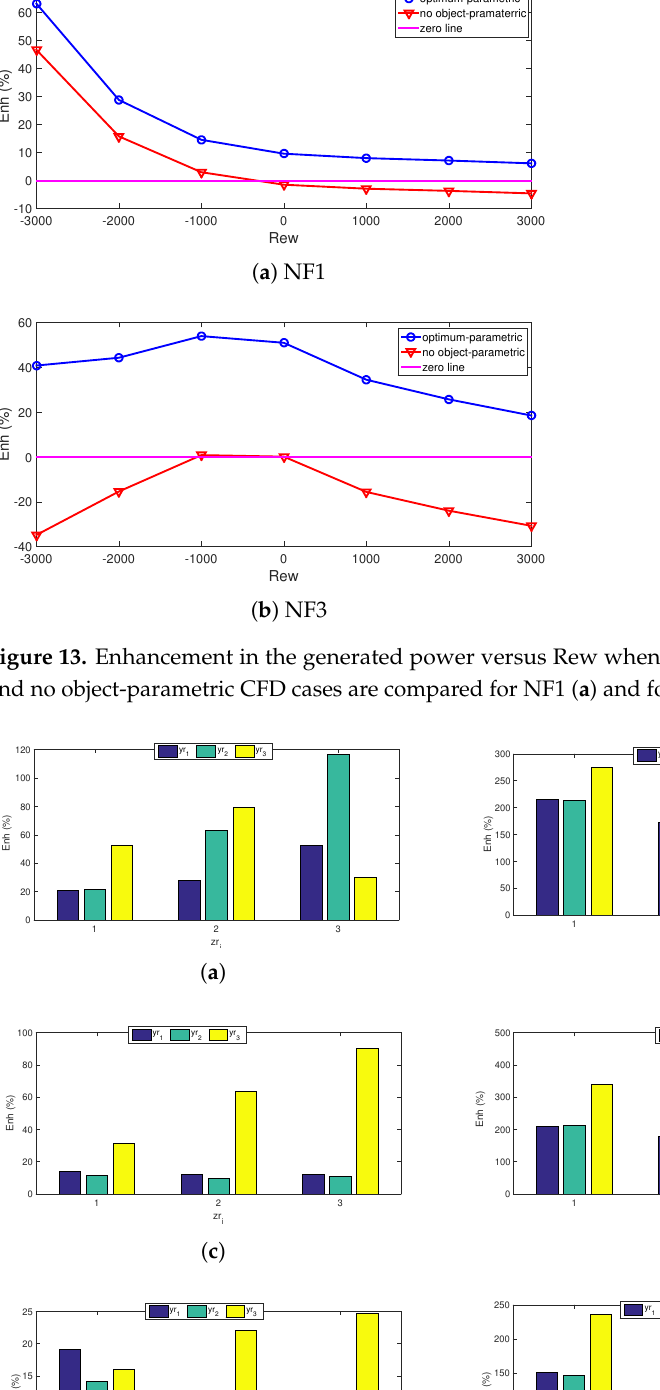
Figure 14. Impacts of the rotating cylinder location in the VC on the enhancement of the generated power when optimum-parametric CFD cases are compared for NF1 and for NF2 at various Rew values. ( a ) NF1, Rew = − 3000, ( b ) NF3, Rew = − 3000, ( c ) NF1, Rew = 0, ( d ) NF3, Rew = 0, ( e ) NF1, Rew = 3000, ( f ) NF3, Rew =